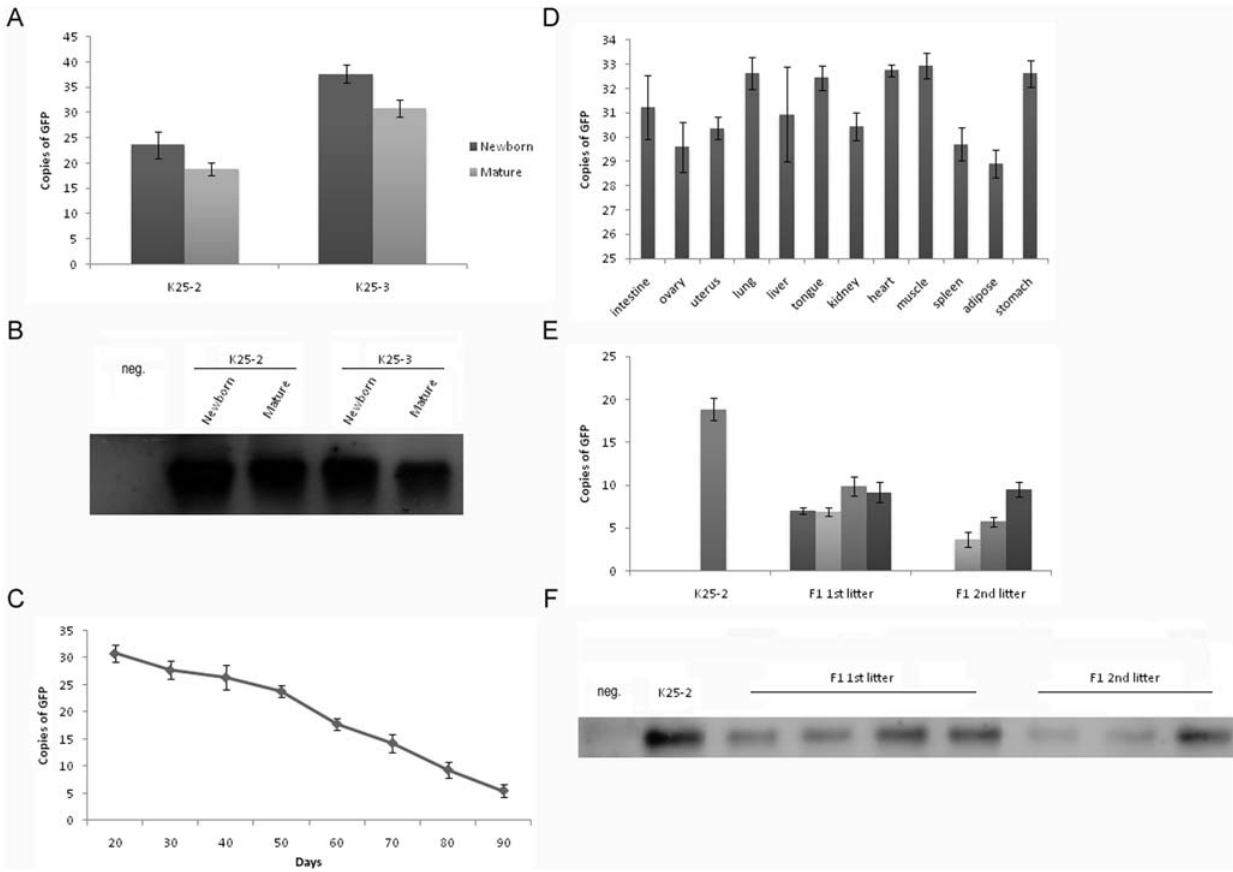
Figure 3. Copy number of GFP. (A) Absolute quantitative real-time PCR analysis of GFP copy number from newborn to maturity in founder transgenic pigs. There was no statistically significant decline in K25-2 (p=0.099), but the decline in K25-3 was significant (p=0.016); (B) Southern blots analysis of GFP copy number in newborn and mature transgenic pigs; (C) Absolute quantitative real-time PCR analysis of GFP copy number in transgenic fibroblast cells. Copy number of GFP declined in cells over time in culture. The decline was significant (p , 0.001); (D) Variegation of GFP copy number in various tissues of transgenic pig. Variegation of GFP copies was shown in different tissues (p=0.059); (E) Absolute quantitative real- time PCR analysis of GFP copy number in offspring transgenic pigs. The decline from founder to offspring was significant (p , 0.001); (F) Southern blots analysis of GFP copy number in offspring transgenic pigs. Error bars denote standard deviations. Neg., non-transgenic pig.